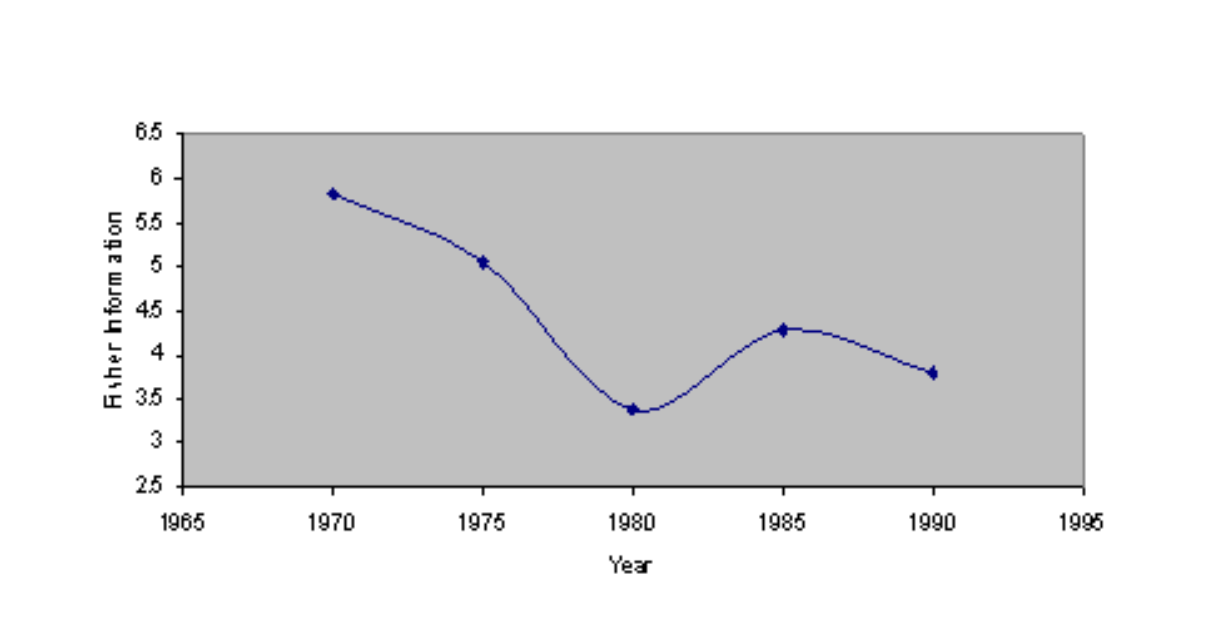
Fig. 3. Fisher information: climate